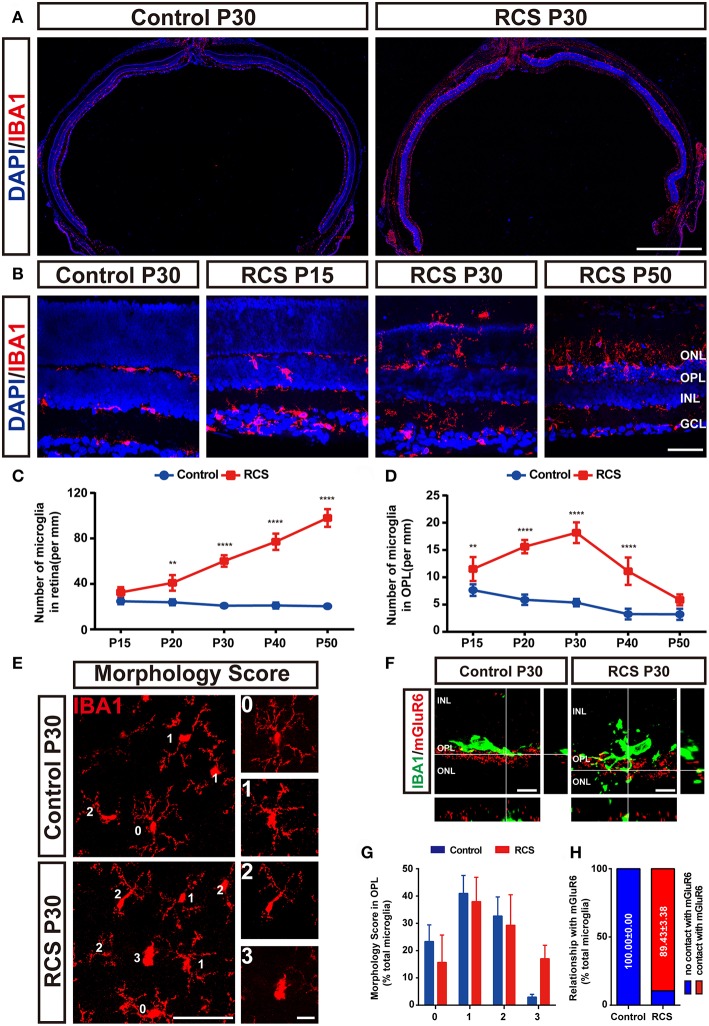
Increased number of microglia and their relationship with synaptic elements in the retinas of RCS rats. (A) Representative panoramic images of retinal sections stained with DAPI (blue) and IBA1 (red) from P30 control and RCS rats. (B) The distribution of microglia [IBA1 (red)] in the retinas of P30 control rats or P15, P30, and P50 RCS rats. (C) Quantification of the number of microglia in the total retinas indicated that the number of total retina microglia increased from P15 to P50 because of photoreceptor apoptosis (N = 3 eyes from different rats, n = 3 panoramic section images from each eye). (D) Quantification of the number of microglia in the OPL, indicating that the number of microglia in the OPL peaked at P30 (N = 3 eyes from different rats, n = 3 panoramic section images from each eye). (E) The morphology of the Iba1-positive cells in the OPL of flat-mounted retinas was examined. For morphology, a score of 0–3 points is shown in the right insets. (F) An orthogonal view of high-resolution confocal images suggested that microglia (green) processes extended into synapse lamination and contacted synaptic material (red) in the OPL of P30 RCS rats compared to controls. (G) No difference in morphological scores of microglia in the OPL was observed between RCS and control rats at P30. (N = 3 eyes from different rats, n = 5 flat-mounted images from each retina). (H) Almost all of microglia in the OPL contacted synaptic material in the RCS rats at P30. (N = 4 eyes from different rats, n = 10–15 microglia from each retina). ONL, outer nuclear layer; OPL, outer plexiform layer; INL, inner nuclear layer; IPL, inner plexiform layer; GCL, ganglion cell layer. Scale bar, 1 mm (A), 50 μm (B and E) or 10 μm (E and F). Bars represent means; error bars represent SD. **p < 0.01, ****p < 0.0001 using two-way ANOVA (C,D,G).